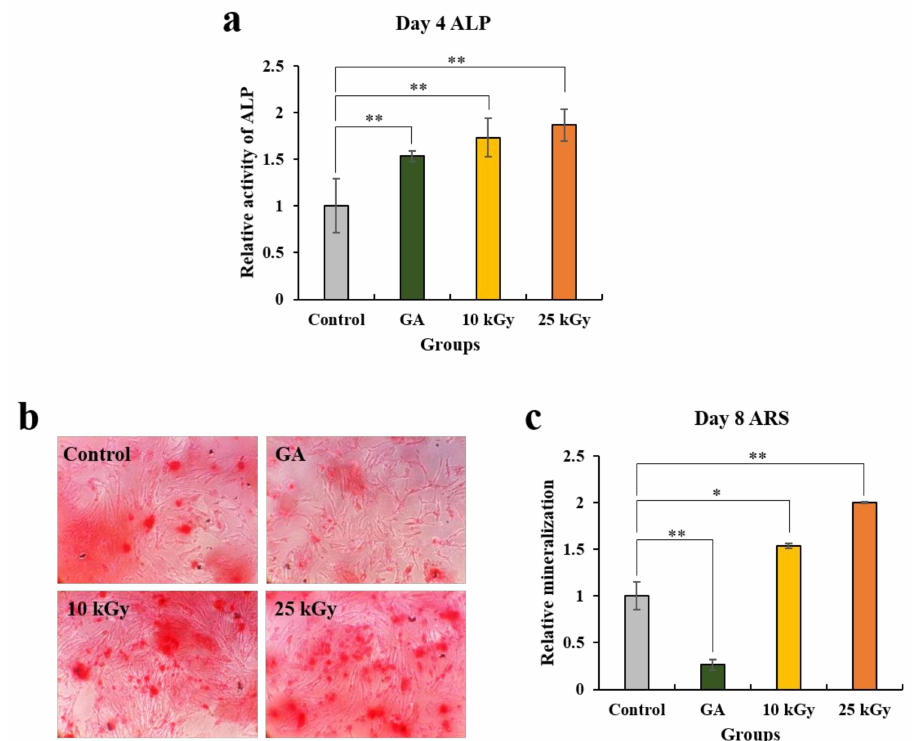
Figure 4. Cell osteogenic differentiation assay. ( a ) Alkaline phosphatase (ALP) activity assay and Alizarin Red S (ARS) ( b ) staining and ( c ) the quantitative analysis. Data are mean ± SD. n = 3. The symbol “*” indicates statistical significance compare to control (* p < 0.05, ** p <